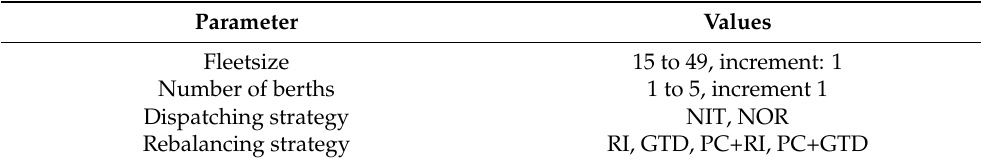
Table 3. Overview of simulation